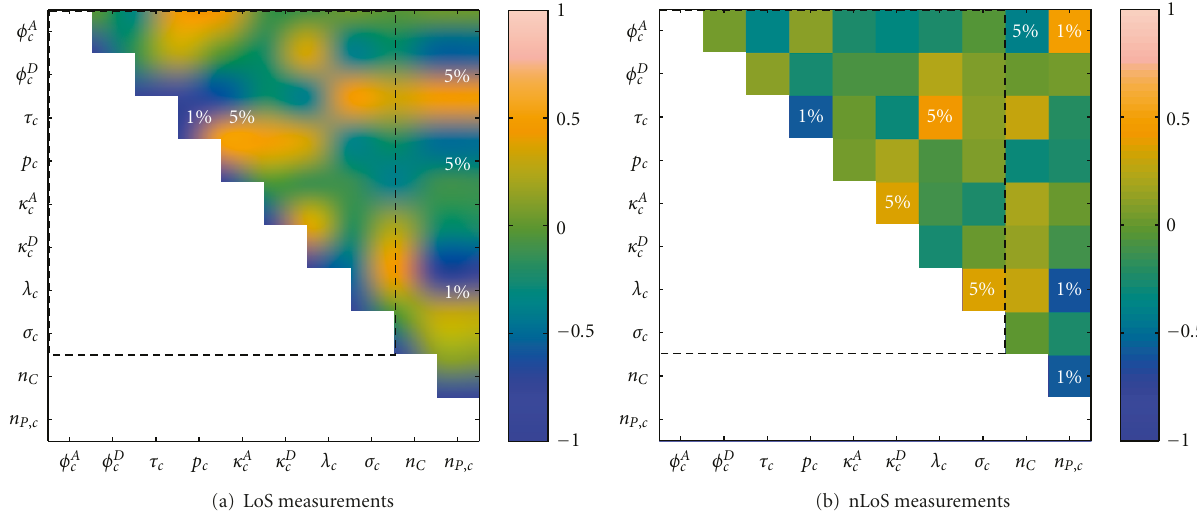
Figure 7: Spearman’s correlation of distributional and number